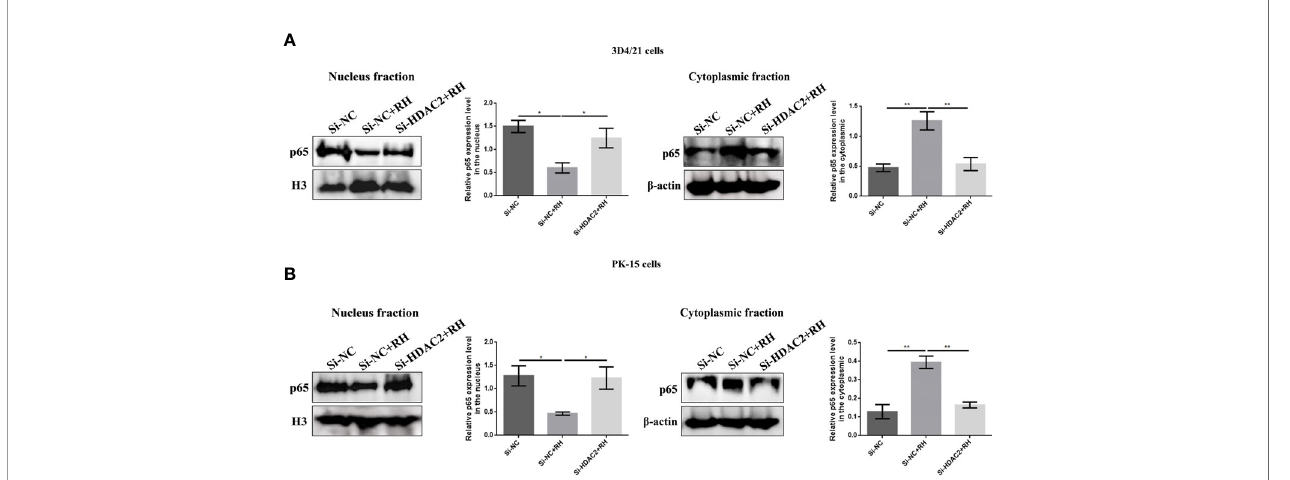
FIGURE 7 | Effects of HDAC2-regulated histone crotonylation on NF- k B activation. (A) The expression levels of NF- k B p65 in 3D4/21 cells were measured by Western blotting. (B) The expression levels of NF- k B p65 in PK-15 cells were measured by Western blotting. *p < 0.05, **p < 0.01, one-way